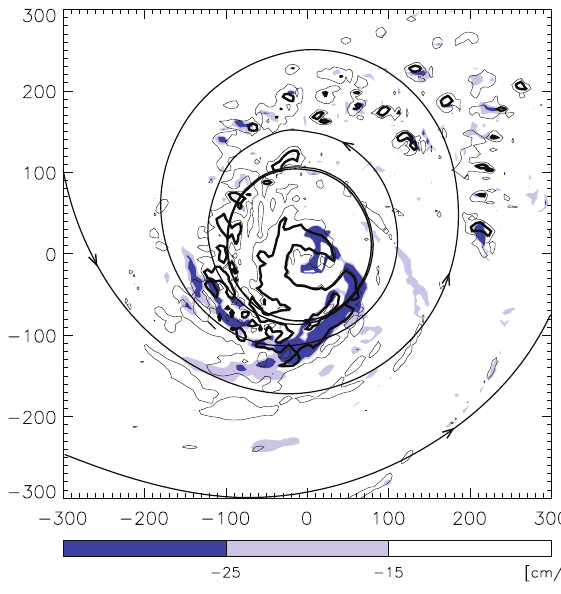
Figure 5. Downdrafts (colored) and flow topology at 2 km and updrafts at 8 km (contours, thin = 0.25 ms − 1 , thick = 1 ms − 1 ). Note that the limit cycle appears as a “thick contour” also because the manifold is plotted several times in a very similar location. The horizontal scale is in km.